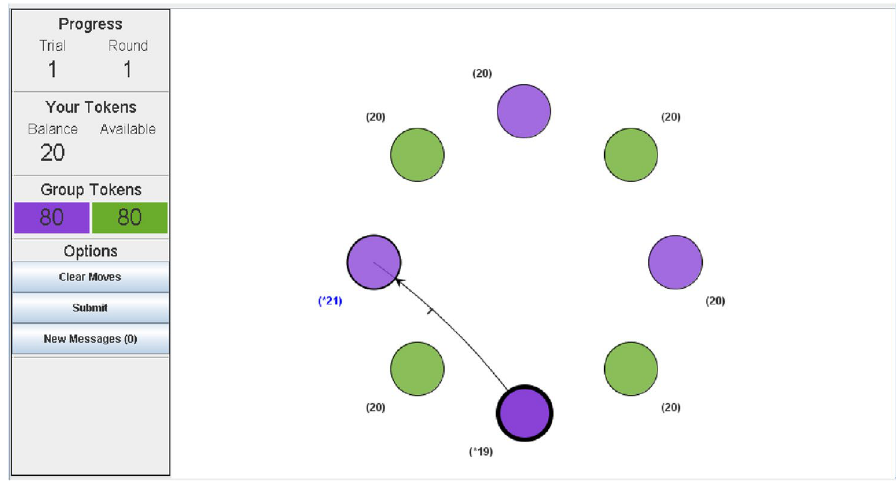
Figure 1. VIAPPL screen presented to a player as they select who they will allocate a token to.